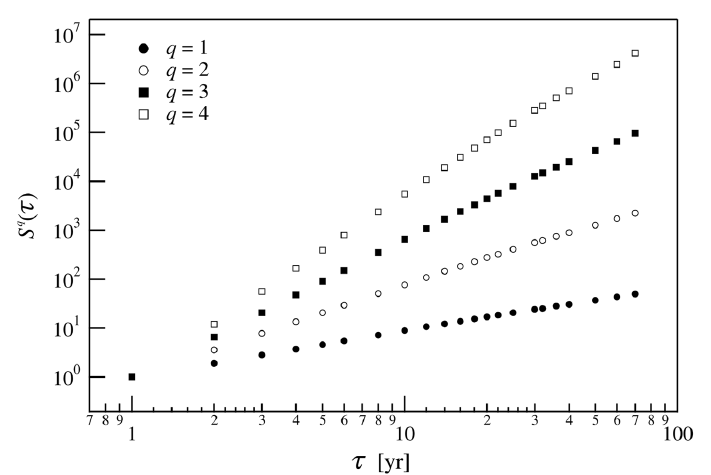
Fig. 3. The behaviour of the structure function S q ( τ ) of the magnetic field fluctuations as a function of τ for a selected number of moment orders. Note the nearly linear trend in the double logarithmic plot meaning that ge- omagnetic field fluctuations are self-similar.